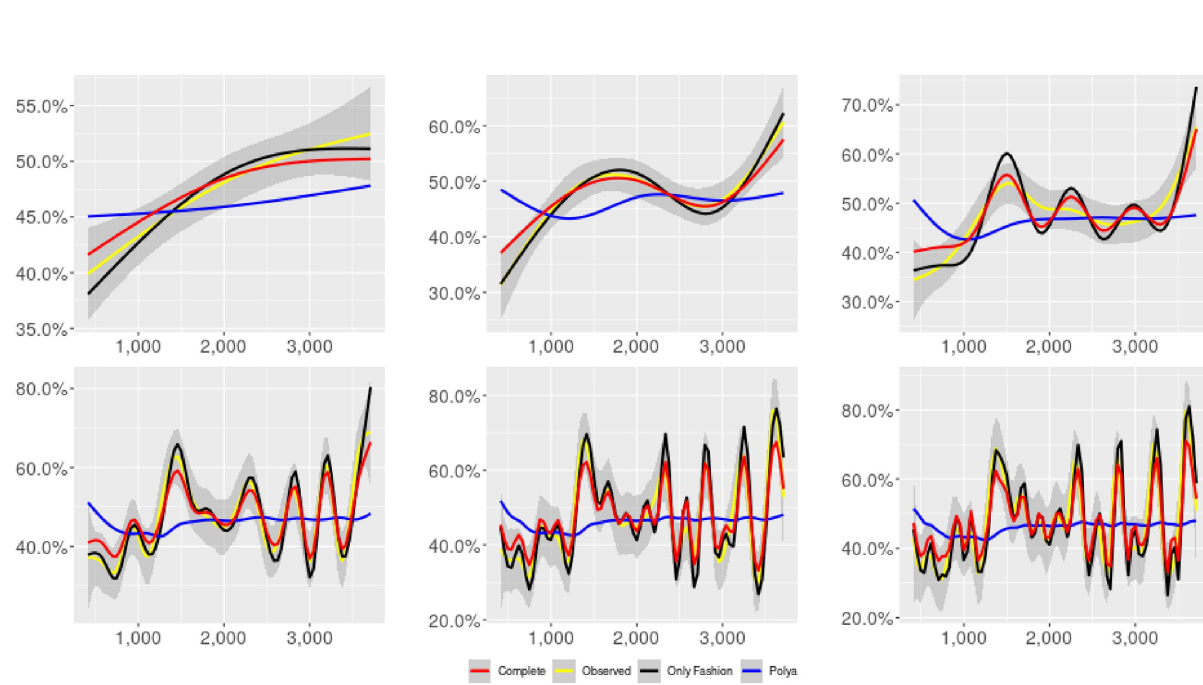
Fig 2. “Migration” ( T = 0.35, only BOTs’ posts, D = 3 0 , S = 100 slots of equal size): Sentiment curves for BOTs’ posts. In each panel, the yellow line is the cubic spline smoothing of the time series of the observed tweets ξ , together with the default confidence interval (gray), the red line represents n +1 the cubic spline smoothing of the time series of the estimated predictive means ^ c (defined in Subsec. 3.2), obtained with the complete RP model, the n black and the blue lines provide similar approximations obtained with the other models: black = Only fashion RP model and blue = Standard Po´lya model. In each panel, the smoothing is obtained with a given number of nodes: k = 3 (top left panel), 5 (top middle panel), 10 (top right panel), 20 (bottom left panel), 30 (bottom middle panel), 50 (bottom right panel).